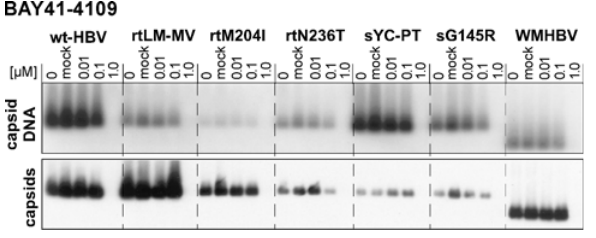
Fig 5. Cell line-borne HBVs with NA resistance-associated and S mutations as well as WMHBV are similarly sensitive to BAY41-4109 as wt-HBV. The indicated cell lines were treated with BAY41-4109 at the indicated concentrations; mock refers to treatment with 0.1% (v/v) DMSO vehicle alone. Equal aliquots from cytoplasmic lysates were analyzed for capsid DNA and capsids as in Fig 3. Note the strong decline in both capsids and capsid DNAs between 0.1 to 1.0 μ M, as expected from the drug´s